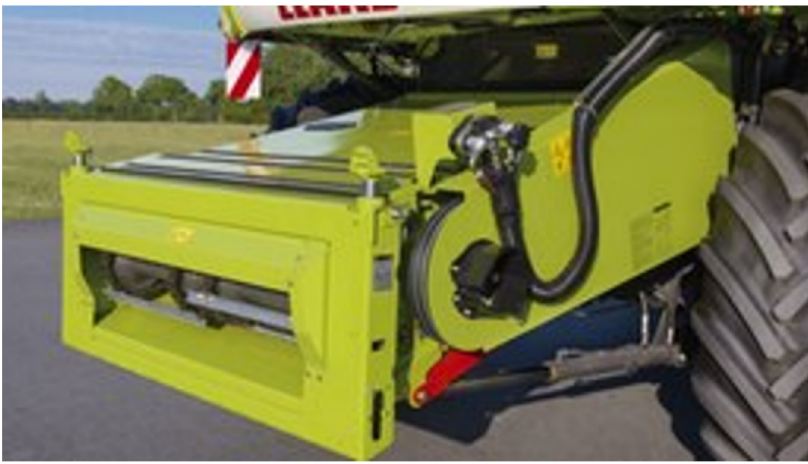
Figure 2. Feeding house attached to the combine harvester body and ready to be attached with a cutting head.